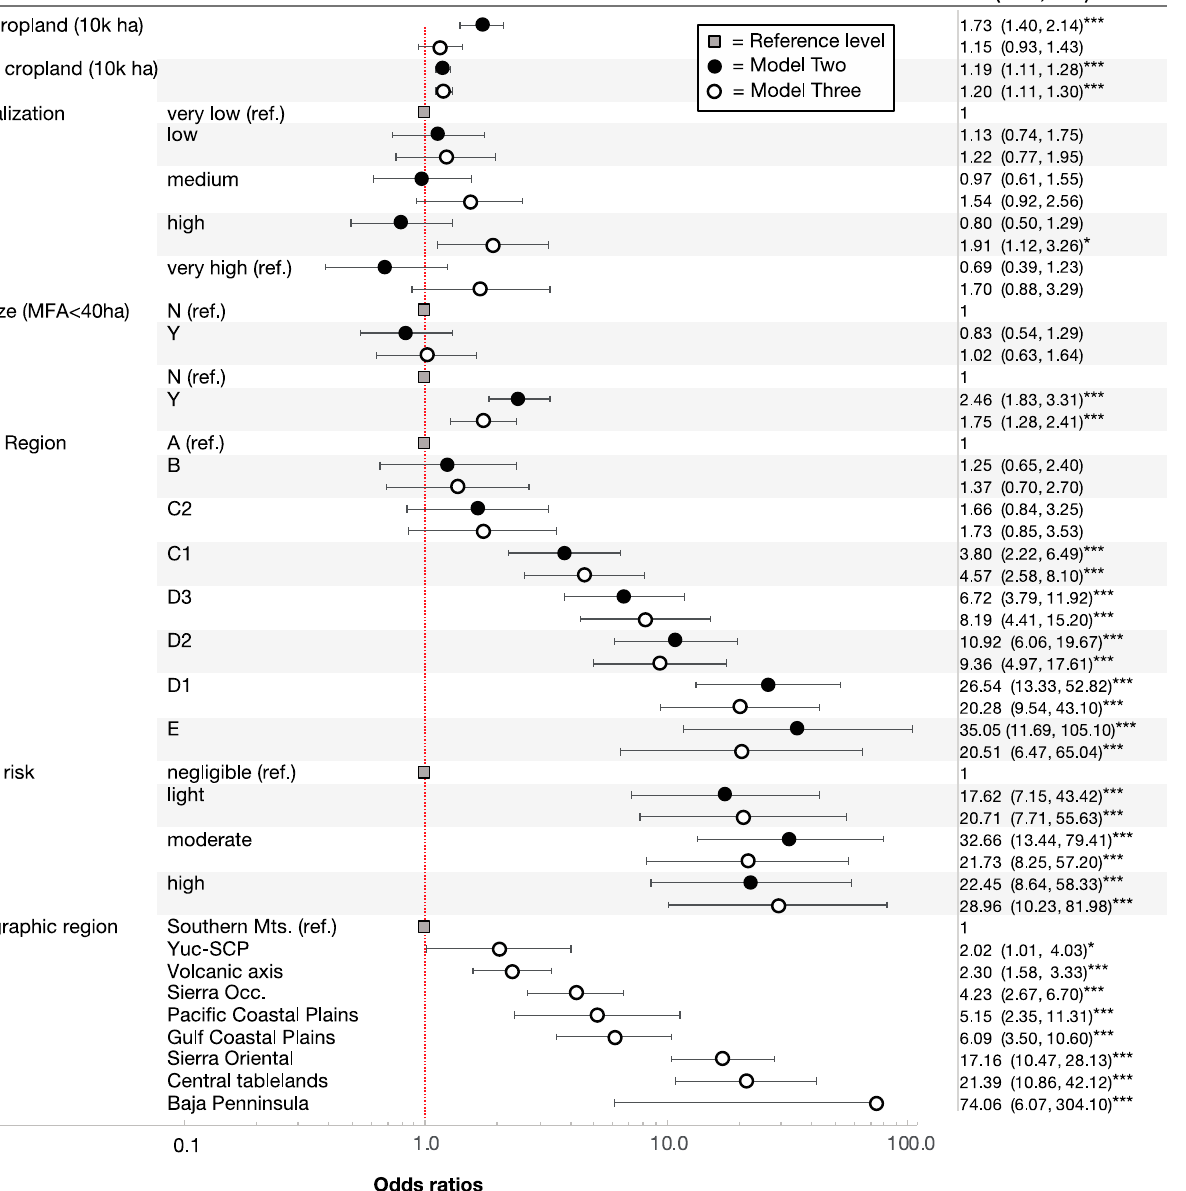
Figure 2. Positive odds ratios for Models 2 and 3 expressed as the likelihood of AEM(Y), lower- and upper-95 percent confidence intervals (LCI and UCI), and significance tests. Models 2 and 3 remain statistically separate but are aligned to illustrate the adjustment effects of adding the physiographic region variable. For continuous variables odds reflect one-unit (10k ha) increases. For categorical variables odds are expressed in relation to reference levels (ref.). For clarity, log scale is used on the x -axis, and the UCI of the Baja Peninsula physiographic region is omitted. * p ≤ 0.05; ** p ≤ 0.01; *** p ≤ 0.001.